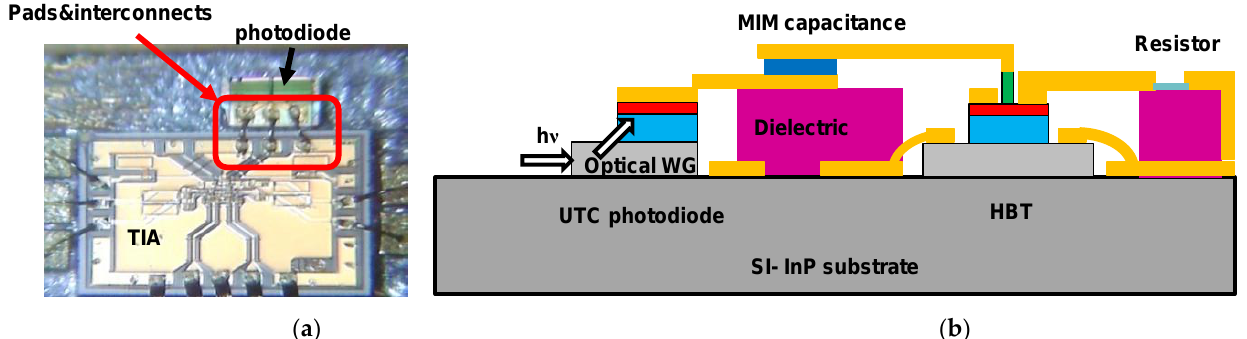
Figure 1. Schematic view of the integration of photodiode and InP heterojunction bipolar transistor (HBT) based trans- impedance amplifier (TIA) on the same substrate: ( a ) top view of the two dies bound together with three wire bondings highlighted with the red arrow, the electronic and the photonic modules; and ( b ) schematic view of the integration of the Uni-traveling-Carrier (UTC) photodiode and the HBT on the same substrate with integrated optical waveguide (WG) and metal-insulator-metal (MIM) capacitance.